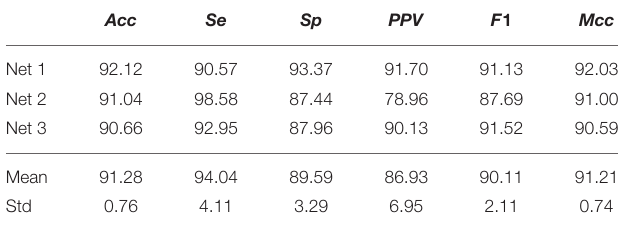
TABLE 3 | ECM-images classification performance from CNN on the validation subsets from the NSRDB and LTAFDB.